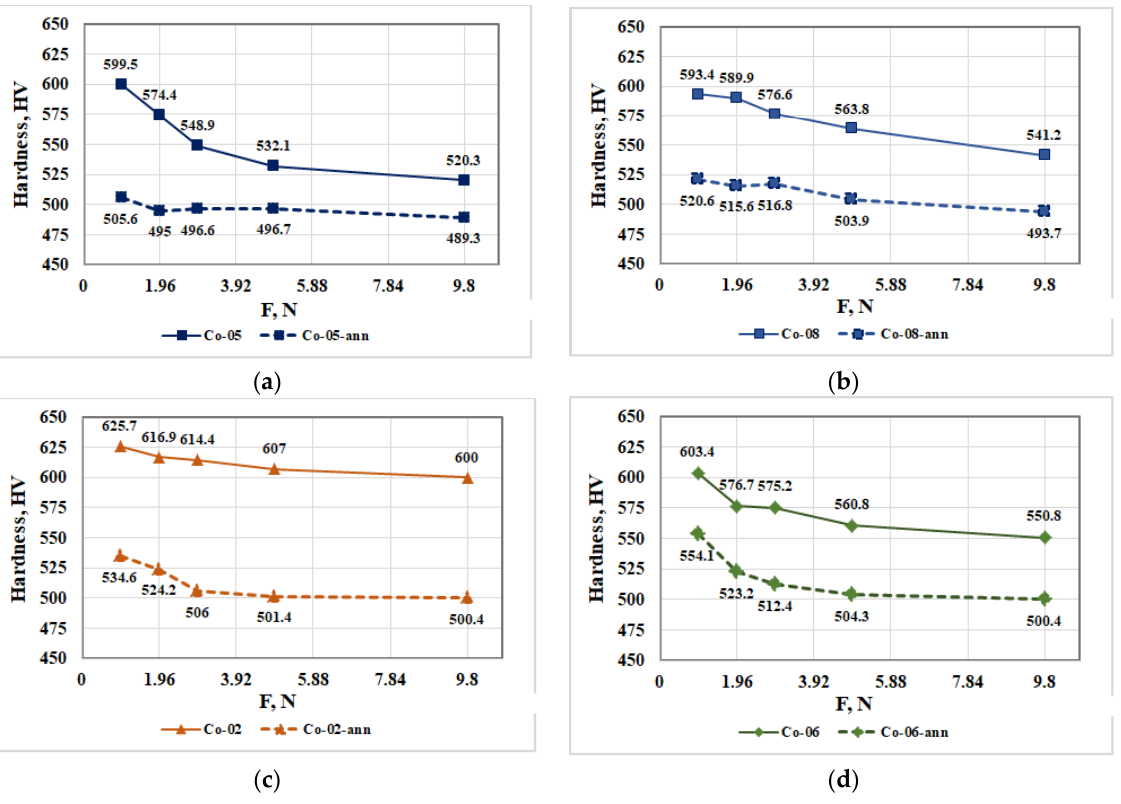
Figure 7. Influence of load on the hardness of CoCrMo specimens obtained after recycling by EBMR under different processing conditions (solid line) and after their heat treatment (dashed line): ( a ) Co - 05 and Co - 05 - ann; ( b ) Co - 08 and Co - 08 - ann; ( c ) Co - 02 and Co - 02 - ann; ( d ) Co - 06 and Co - 06 - ann.